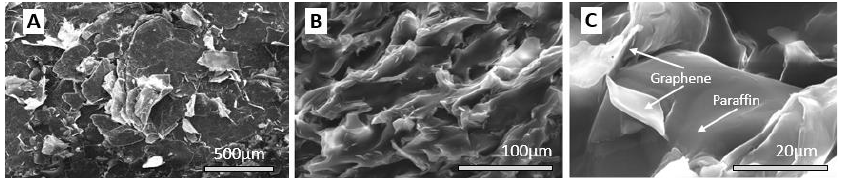
Figure 2. ( A ) Raman spectra of multilayer graphene obtained by supercritical fluid exfoliation; ( B ) AFM topography image of graphenes deposited on silicon wafer substrate, scan area 10 µm × 10 µm and ( C ) scan area 3.7 µm × 3.7 µm; ( D ) cross-section profile evidencing a multilayer graphene thick- ness of approximately 2.35 µm. In order to highlight the morphology of the sample, the surface under investigation was obtained by fracturing the sample after cooling in liquid nitrogen. Figure 3C shows, at different magnifications, the intercalation and homogeneous distribution of graphenes in the paraffin matrix.